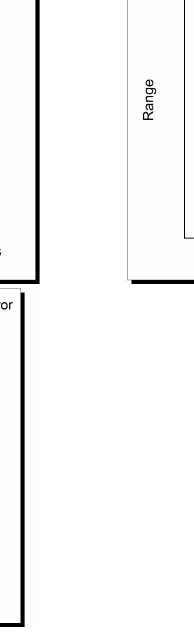
Figure 5. Matching between exact and semi–analytical solutions based on Table